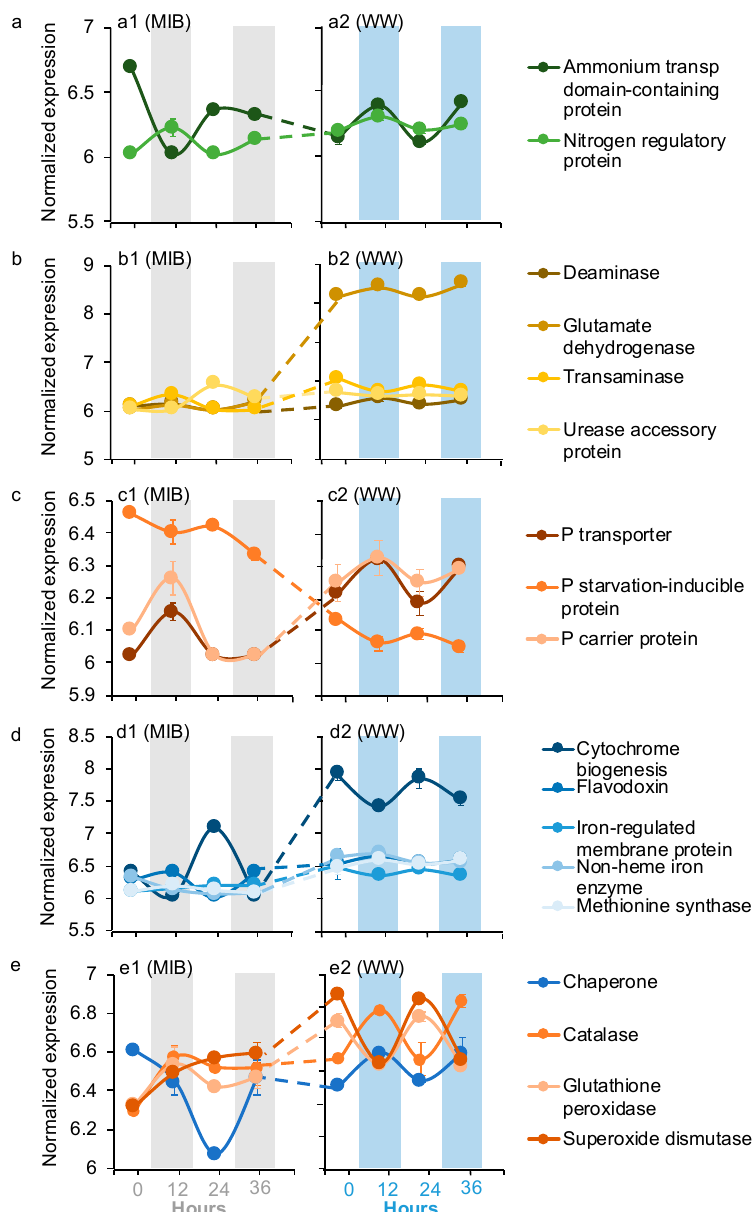
Figure 4. Averages of the normalized microbiome gene expression values based on variance stabilizing transformation in DeSeq2 related to ( a ) nitrogen metabolism, ( b ) organic nitrogen metabolism, ( c ) phosphorus metabolism, ( d ) iron metabolism and methionine synthesis, and ( e ) stress response and H 2 O 2 depletion. Gray bars and blue bars indicate dark condition samples in MIB and WW, respectively. The error bar represents the standard error of the gene expression values.